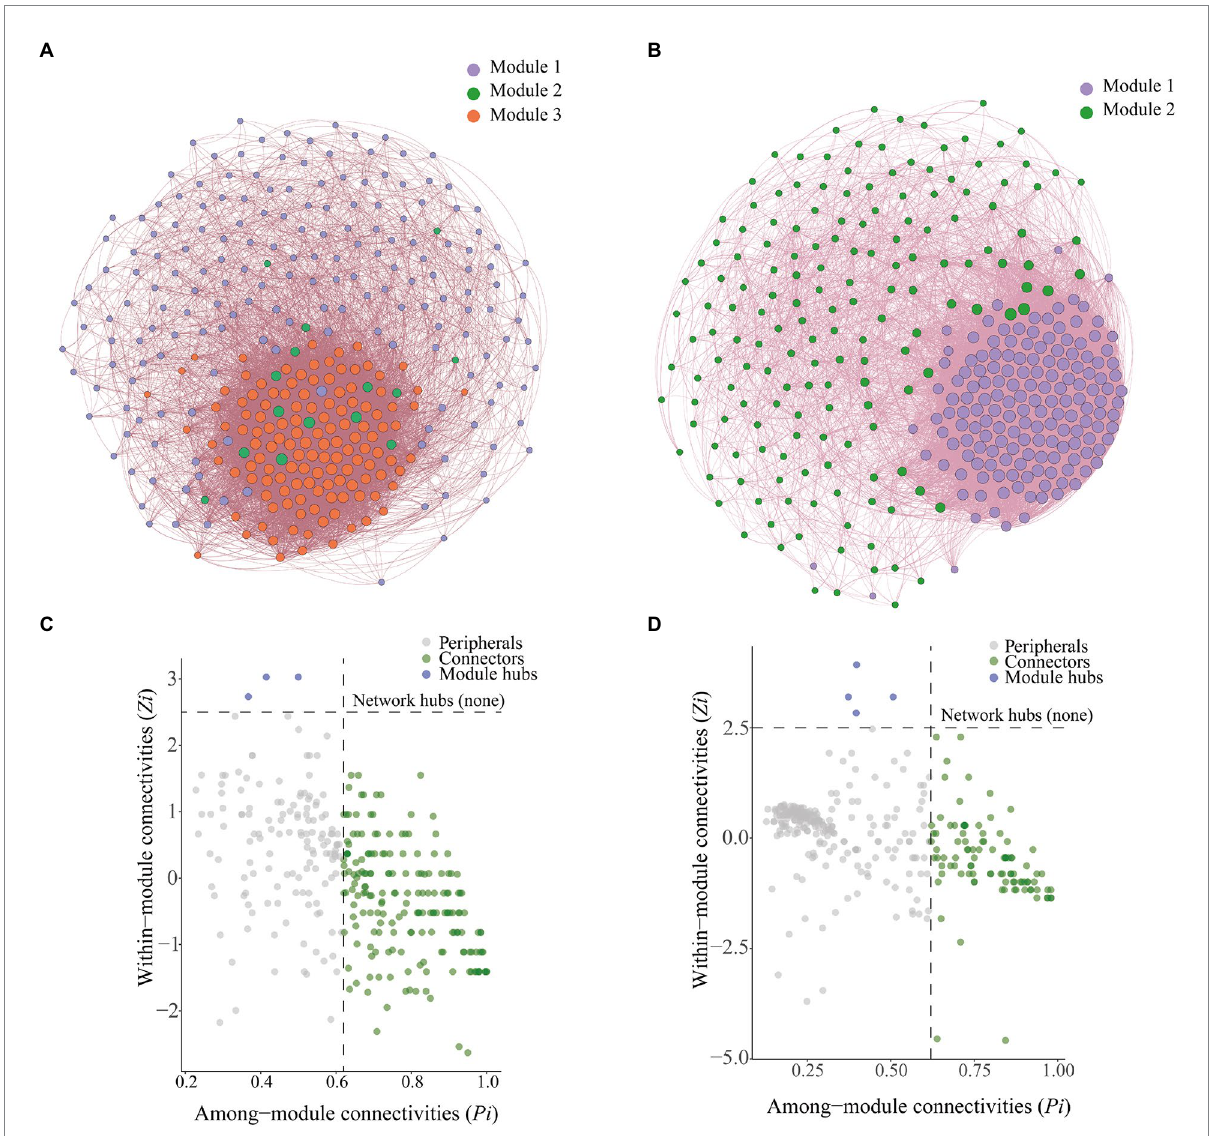
FIGURE 7 Co-occurrence networks and analysis of soil microbial communities. (A) Co-occurrence network of bacteria and fungi with relative abundance greater than 0.1% in bulk soil. (B) Co-occurrence network of bacteria and fungi with relative abundance greater than 0.1% in rhizosphere soil. (C) Zi-Pi plots of bacteria and fungi with relative abundance greater than 0.1% in bulk soil. (D) Zi-Pi plots of bacteria and fungi with relative abundance greater than 0.1% in rhizosphere soil.